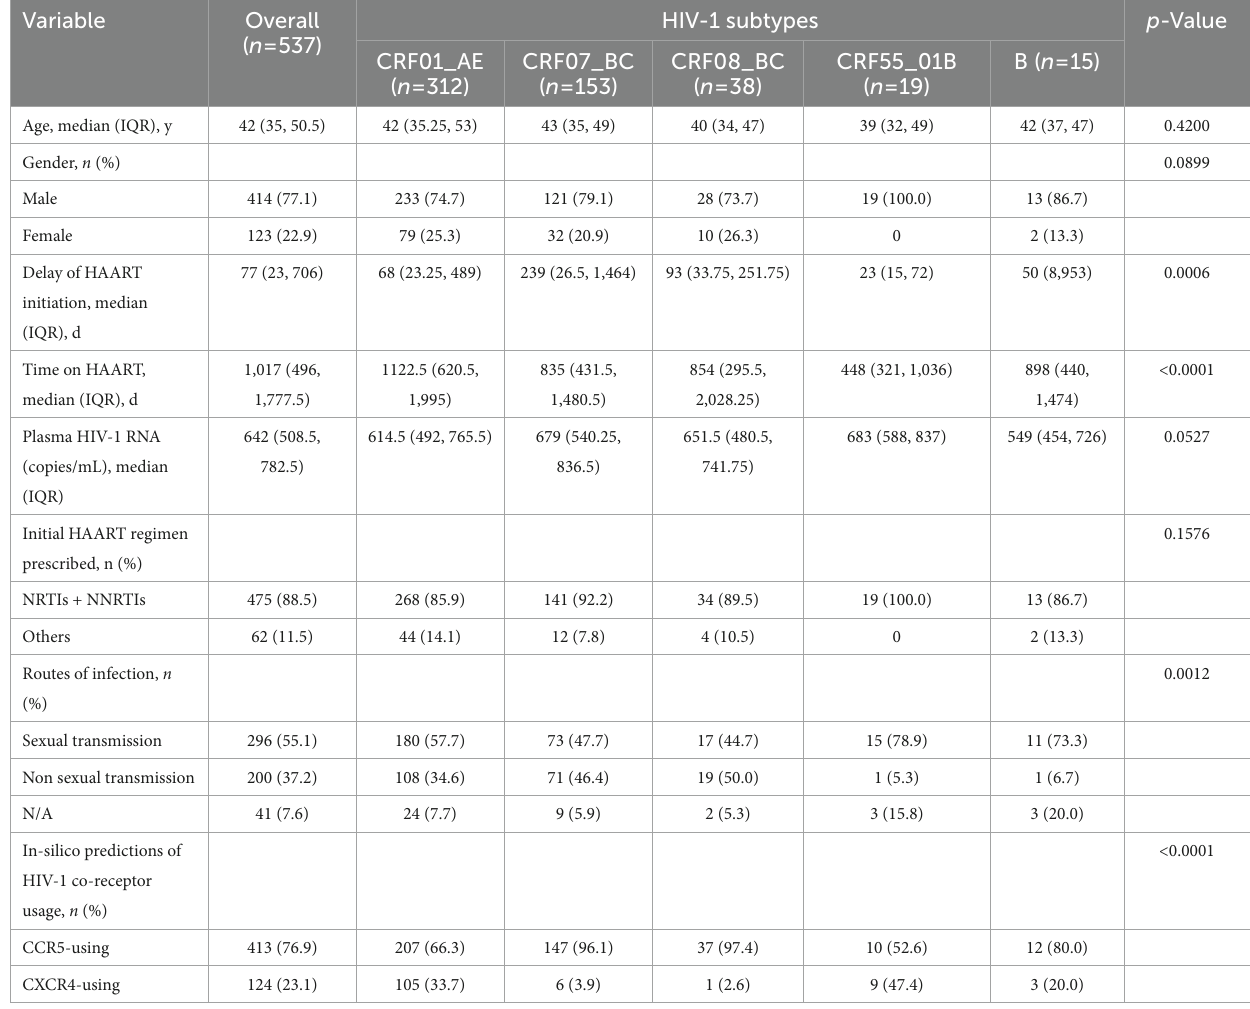
TABLE 2 Demographics and characteristics of the study population ( N =